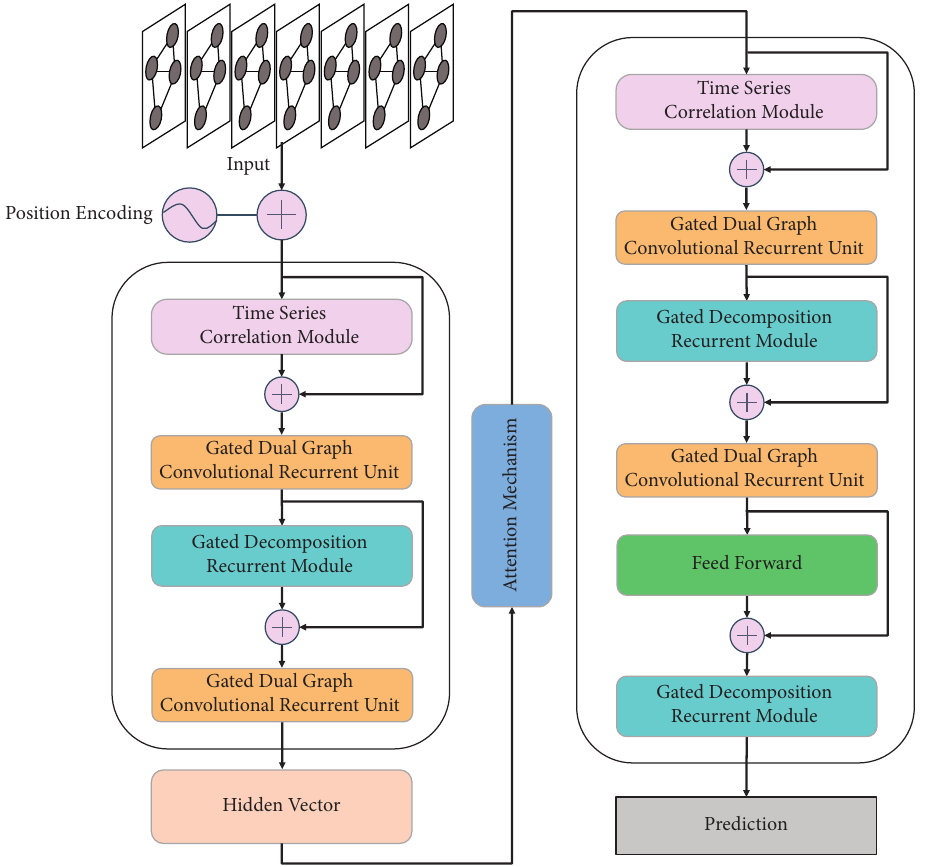
Figure 2: The framework of AED-DGCN-TSC.